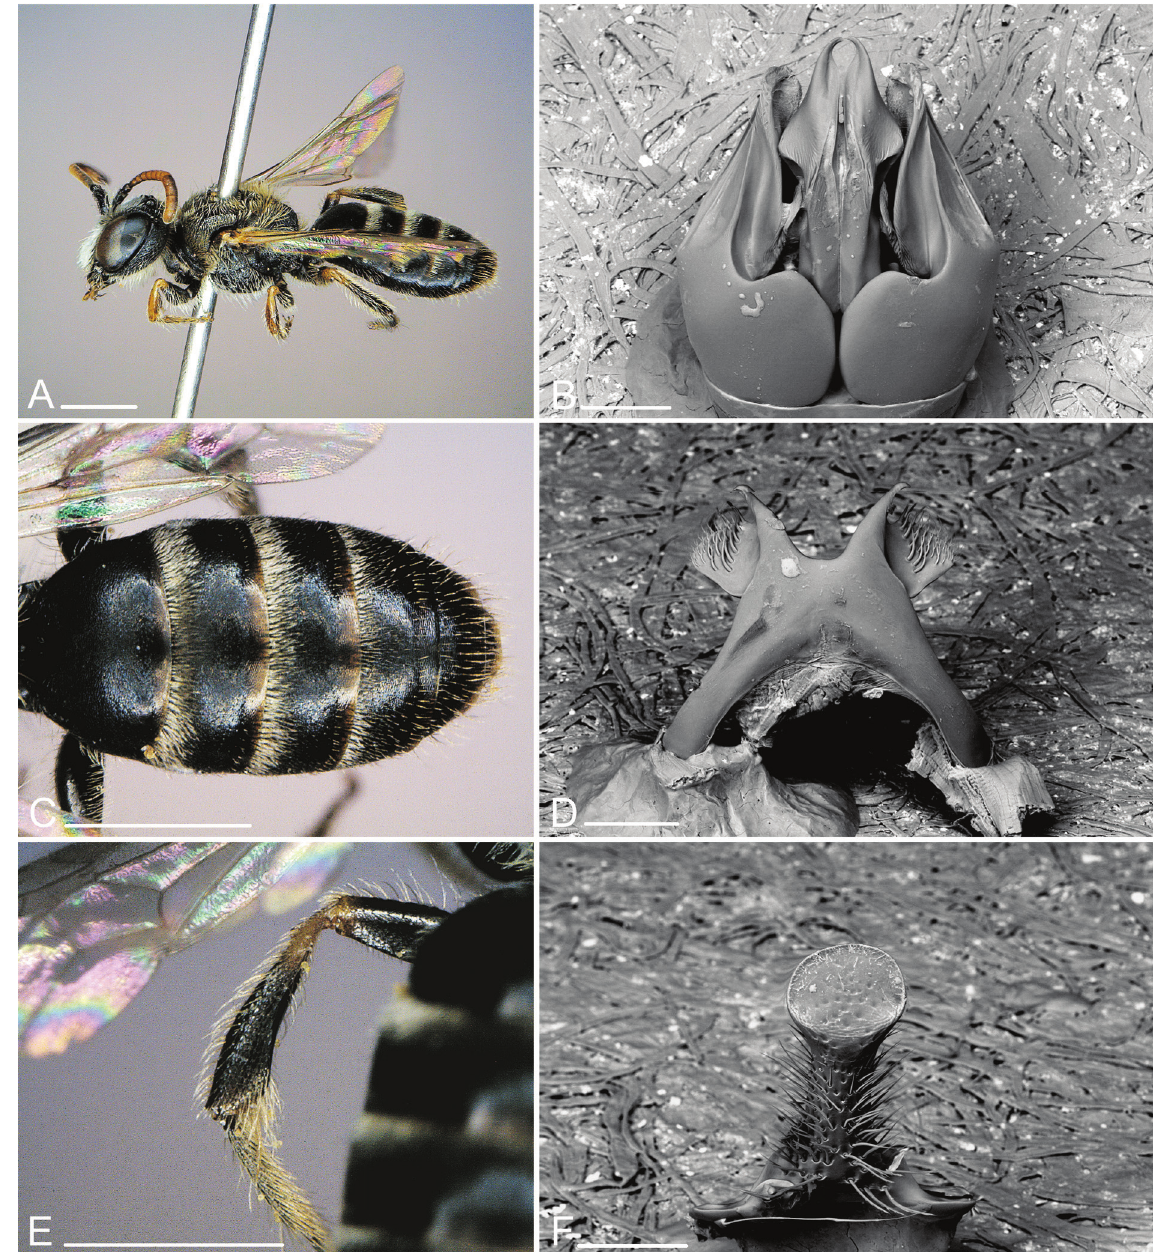
Fig. 29. Scrapter sittybon Davies, 2005, ♂. A . Lateral view. B . Genitalia (dorsal view, SEM). C . Metasoma (dorsal view). D . S7 (dorsal view, SEM). E . Hind tibia. F . S8, apical end (SEM). Scale bars: photos: 1 mm, SEM: 0.1